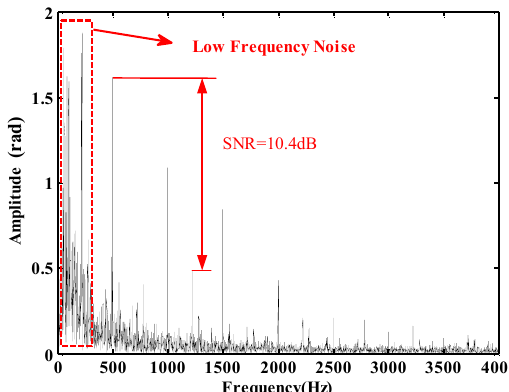
Figure 12. Frequency spectrum of phase curve.